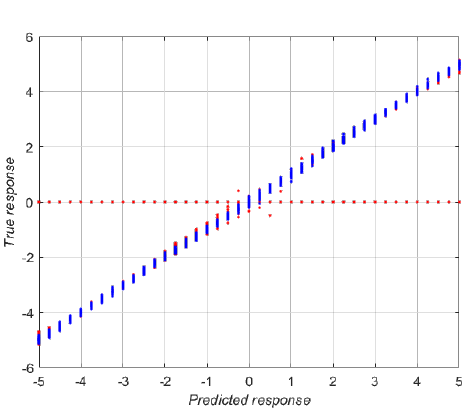
Figure 8. Comparison between the predicted response (x-axis) and the real value (y-axis) of the wide neural network after filtering the input planes. Blue points represent the planes that pass the filtering stage meanwhile red points represent the discarded